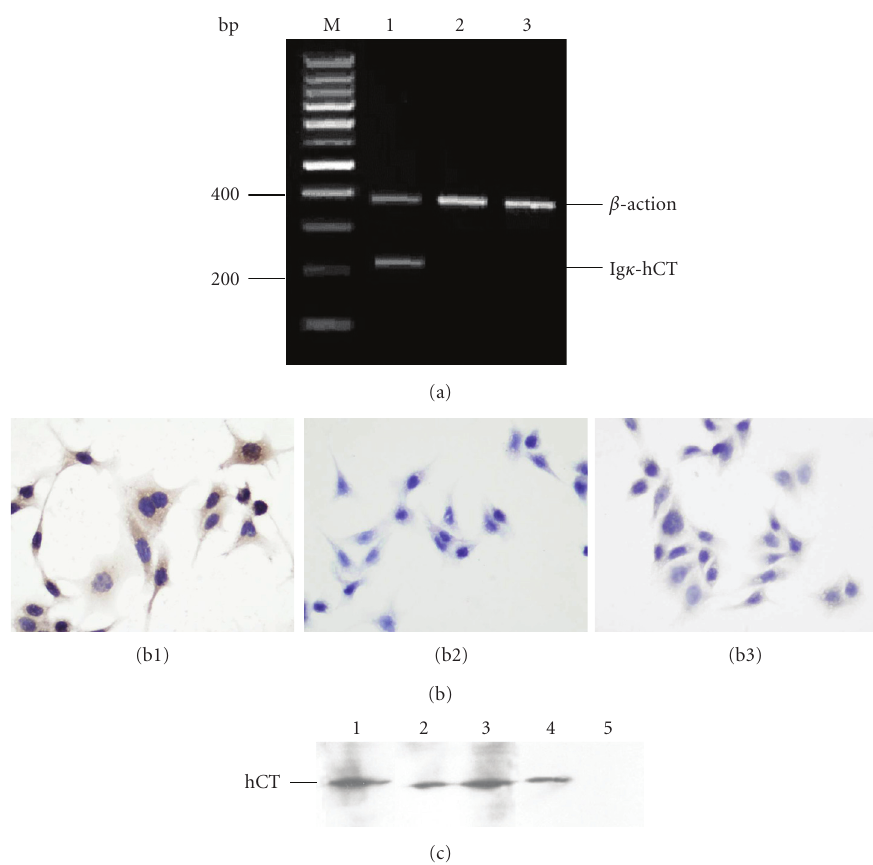
Figure 2: Expression of hCT mRNA and protein in NIH3T3 cells. (a). Ig κ -hCT mRNA expression in NIH3T3 cells by RT-PCR. Lane M: marker; Lane 1: RT-PCR products from pCDNA3.0-Ig κ -hCT-transfected NIH3T3 cells; Lane 2: RT-PCR product from pCDNA3.0- transfected cells (negative control); Lane 3: RT-PCR product from nontransfected cells. (b), Immunohistological staining of hCT protein in pCDNA3.0-Ig κ -hCT-transfected (b1), nontransfected (b2) and pCDNA3.0-transfected NIH3T3 cells (b3). All magnification × 200. (c). Western blotting showing hCT protein was detected in pCDNA3.0-Igk-hCT-transfected cells (lanes 1–4), but not in pcDNA3.0 transfected cells (lane